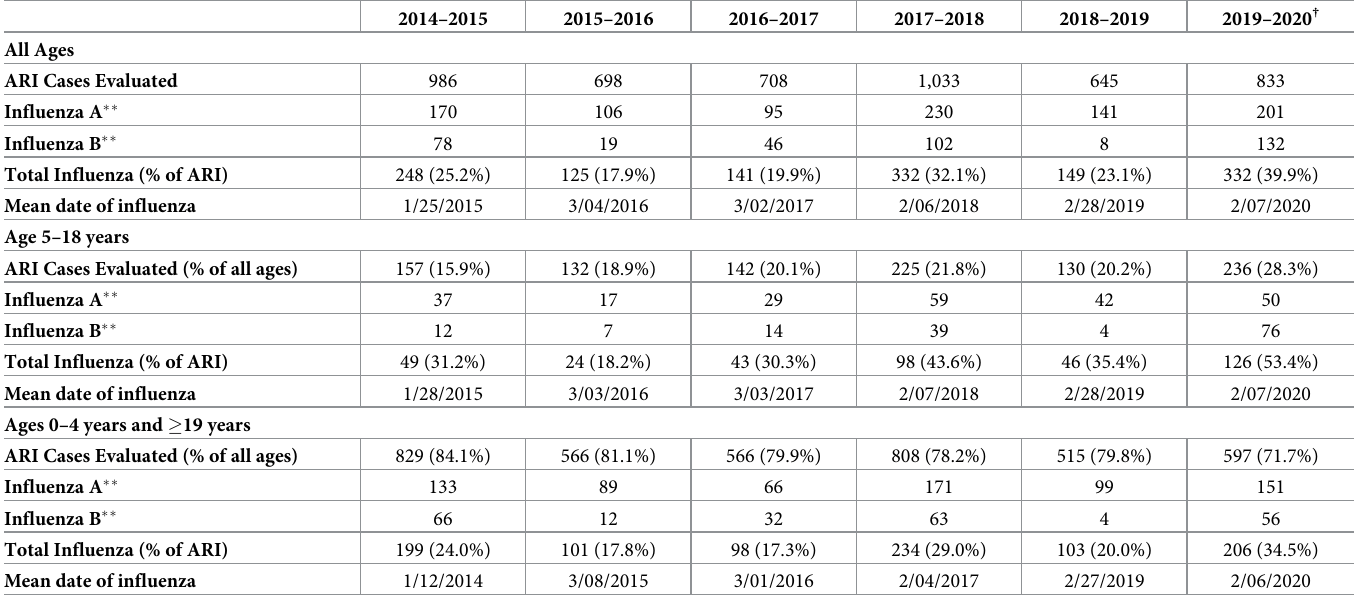
Table 3. Acute respiratory infection (ARI) cases evaluated and numbers of influenza A and B cases detected across six influenza seasons at five influenza surveil- lance clinics, � Dane County, Wisconsin.